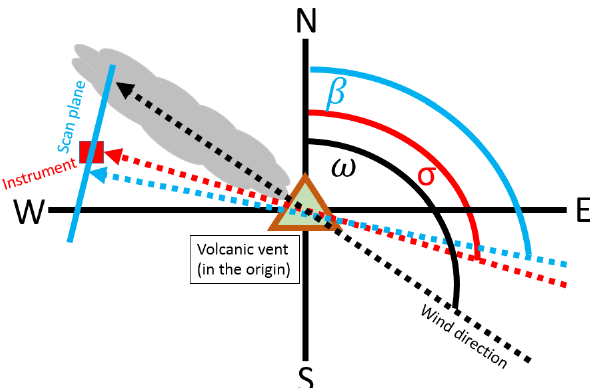
Figure 5. Sketch of the geometric relations which are used to cal- culate the SO 2 emission fluxes, to conduct the plume centre trian- gulation, and to estimate the plume